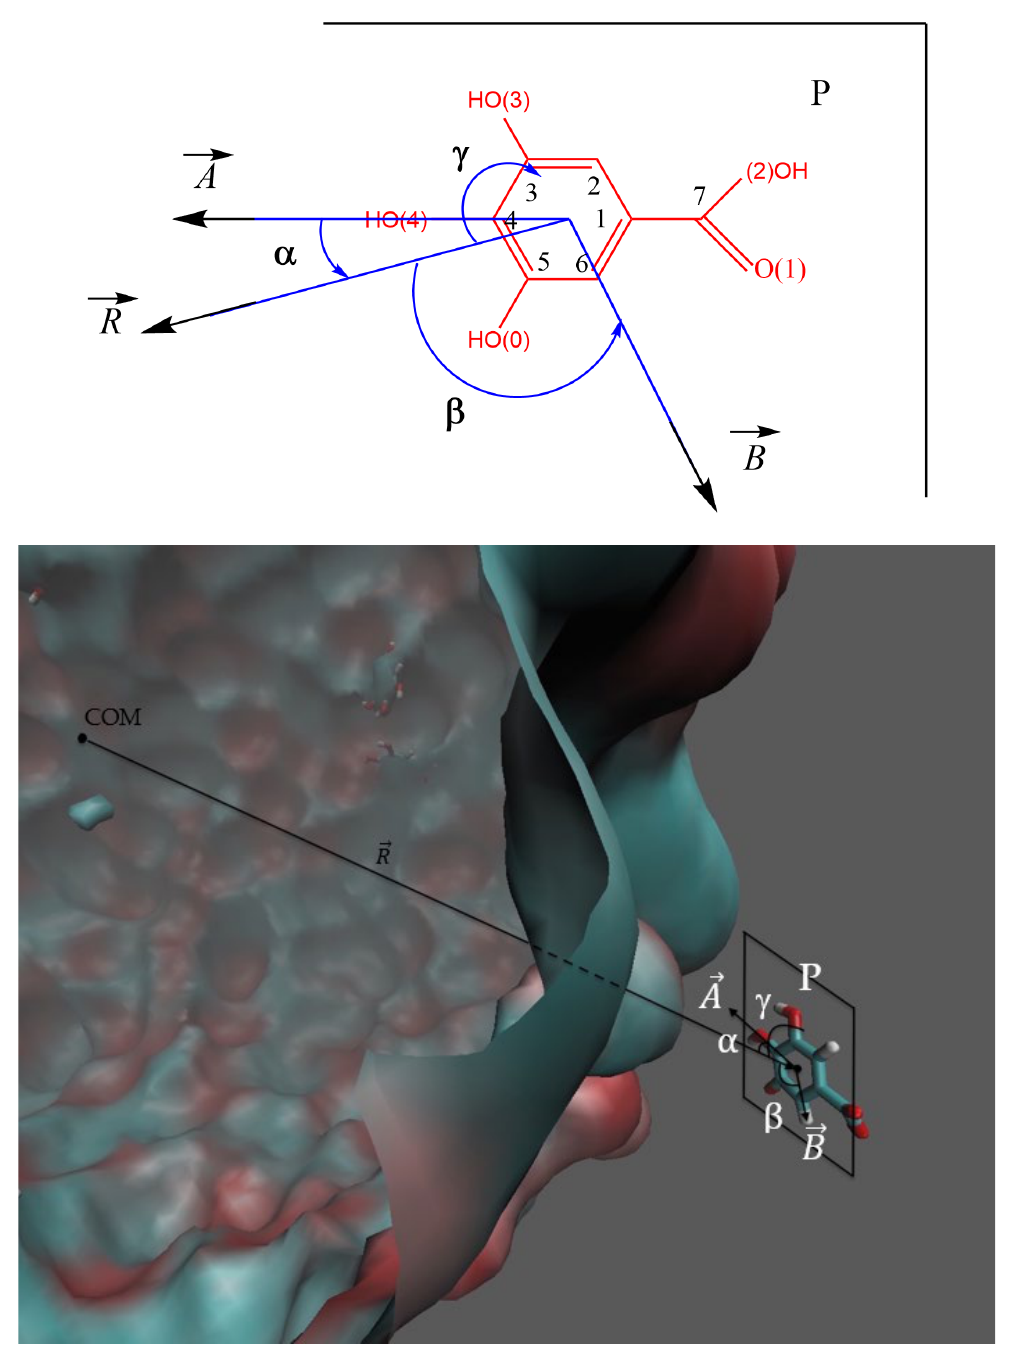
Figure 3. ( Upper ) Detail of the molecular structure of the gallic acid, numbering and vectors used in the simulation and its analysis. Angles and atom numeration established to analyze the orientation of the gallic acid with respect to the nanoemulsion droplet core. The α angle is that between the vector joining the COM of the nanoemulsion (vector ) and the vector contained in the plane P, joining the center of mass of gallic acid and the C4 atom (vector A ). The β angle is that between vector R and vector B contained in the plane. The γ angle between vector R and the molecular plane P. ( Lower ) The computer-simulated picture of the modelled nanoemulsion (MD) and of the gallic acid molecule (both drawn keeping their relative sizes), and the main parameters employed to describe the location and orientation of GA in the nanoemulsion. The atoms of GA are represented according to the following color-coding: C (cyan), H (white), O